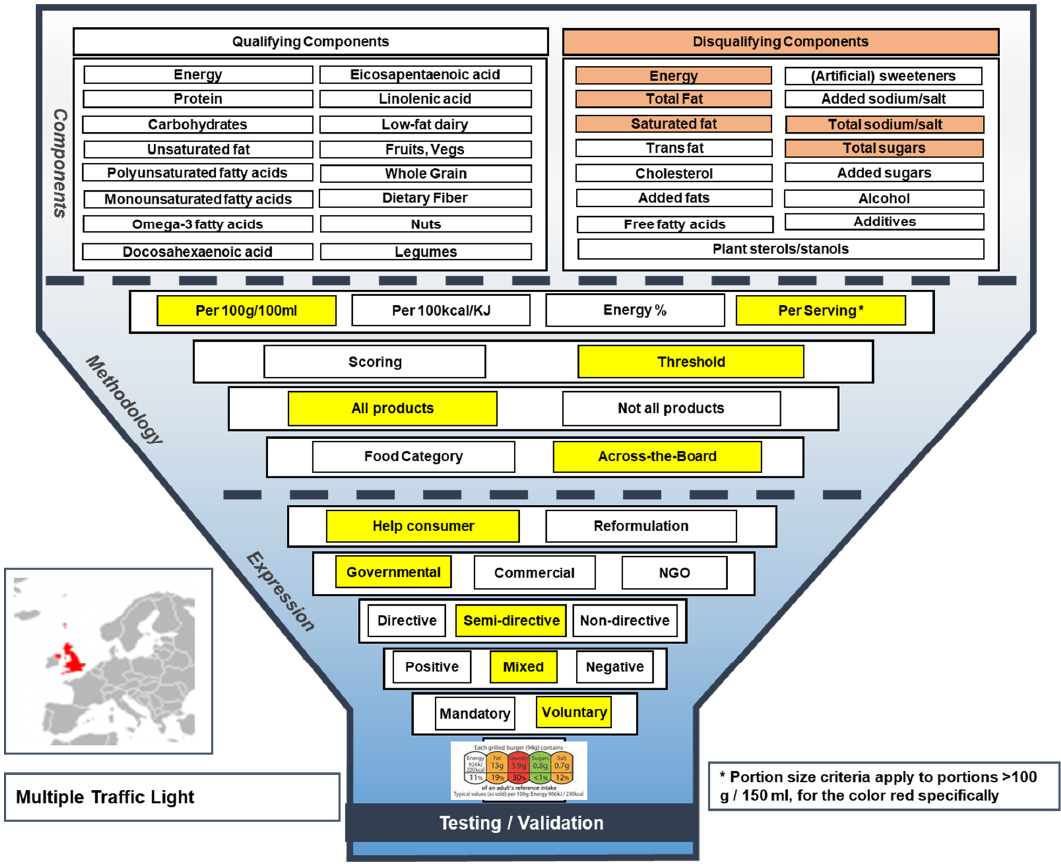
Figure 5. The Funnel Model describing functional and visual aspects of the Multiple Traffic Light scheme.